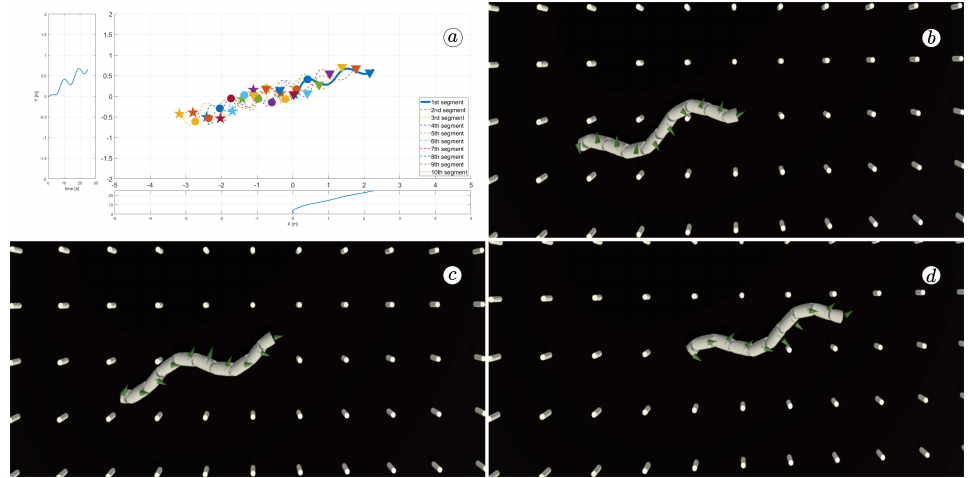
Figure 23. Trajectories of robot segments for φ i ,ref = 50 ◦ sin ( 40 ◦ t + ( i − 1 ) 60 ◦ ) ( a ) and robot configu- rations for t = 5 ( s ) ( b ), t = 10 ( s ) ( c ), and t = 24 ( s ) ( d ).